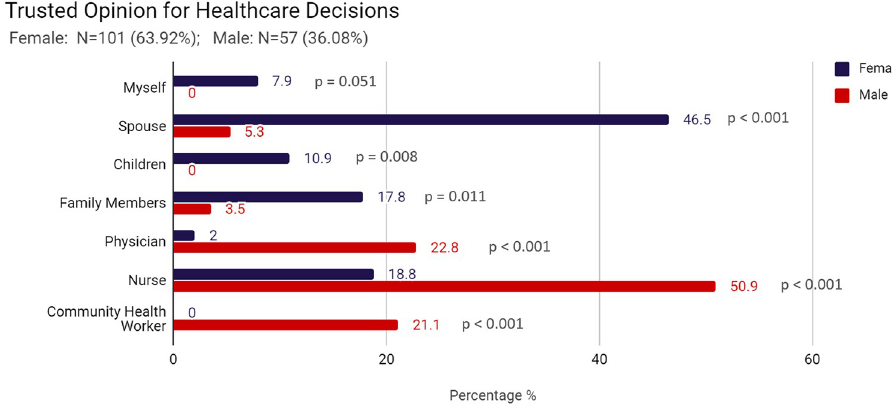
Fig 1. Trusted opinion for healthcare